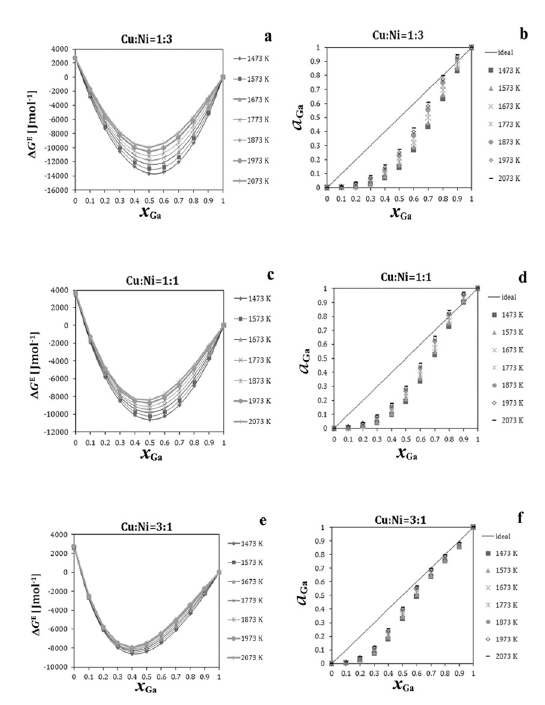
Figure 3: Results of thermodynamic calculation according to GSM in temperature range of 1473-2073K for cross-sections from gallium corner: a) integral molar excess Gibbs energy (ΔG E ) and b) gallium activity for cross section Cu:Ni=1:3; c) Δ G E and d) gallium activity for cross section Cu:Ni=1:1; e) Δ G E and f) gallium activity for cross section Cu:Ni=3:1.